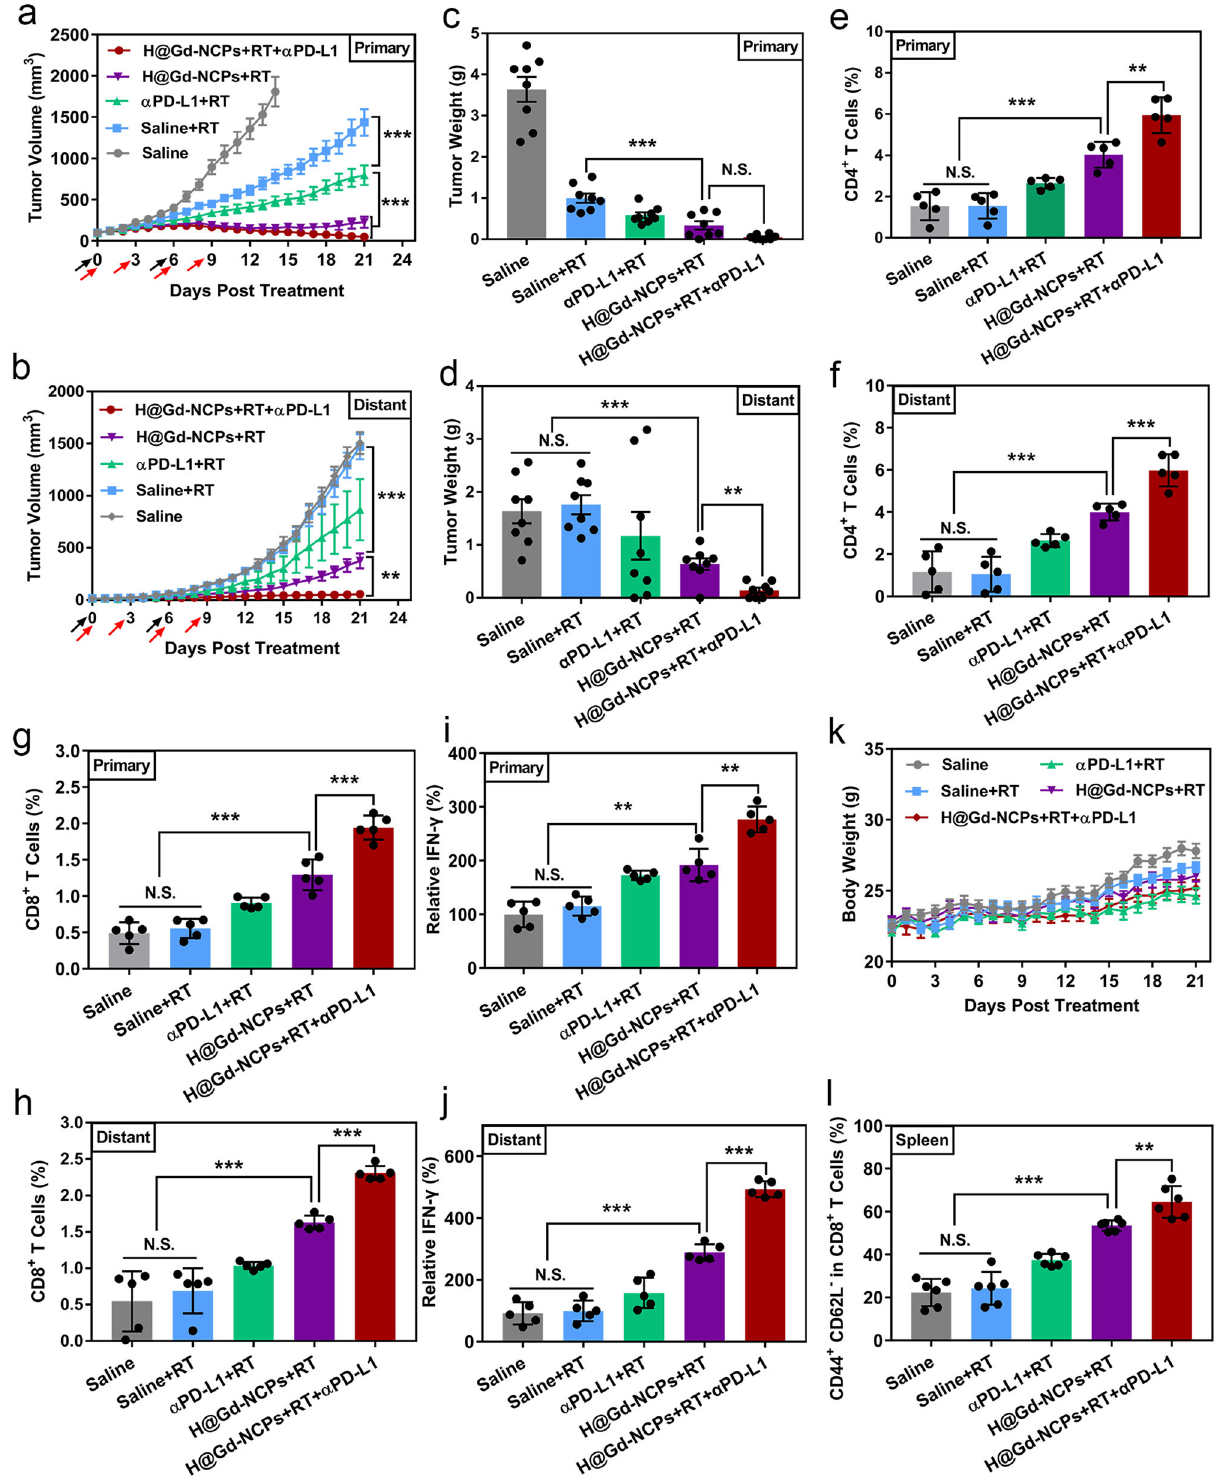
effect in a spontaneous 4T1 metastatic breast cancer model (Fig. 9a). Compared with radiation therapy alone, H@Gd-NCPs sensitized radiation enhanced the primary tumor therapeutic ef fi cacy. Similarly, the optimal tumor inhibition was observed after the synergy with CBI by anti-CTLA-4 antibody ( α CTLA-4) (Fig. 9b – d and Supplementary Figs. 26, 27). Fourteen days after treatment, primary 4T1 tumors and adjacent skin tissues were carefully dissected. As shown in Fig. 9e, f and